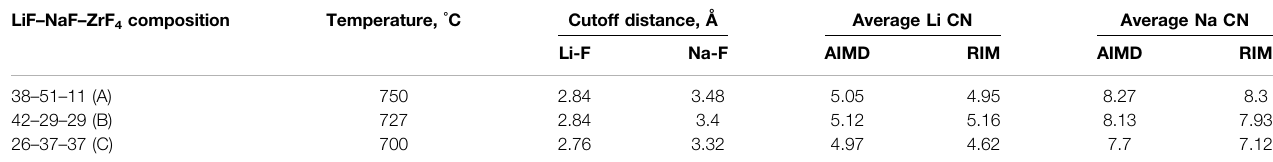
TABLE 2 | Li and Na coordination number as calculated by AIMD and RIM-IPMD.